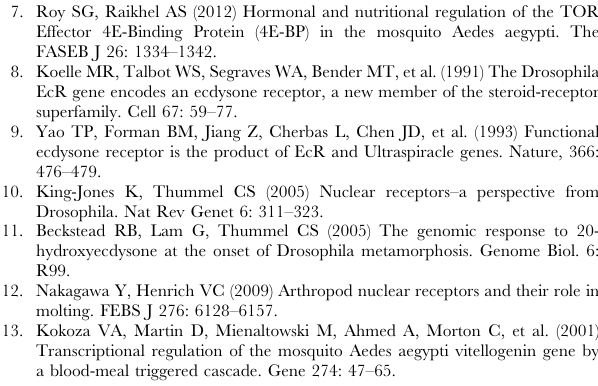
Figure S1 A schematic representation of the 20E- triggered regulatory interactions at the onset of Dro- sophila metamorphosis. The green ovals – EcR/USP 20E heterodimeric receptor; blue boxes – genes that encode 20E regulated transcription factors (early genes); orange boxes – late target genes. Green arrows represent activating effects and red lines represent repressive effects. From [46] with permission. (PDF) Figure S2 Effect of HR3 RNAi depletion on Vg and AaHR3 mRNA levels in the in vitro fat body tissue culture. Three days after dsRNA injection to Aedes female mosquitoes, their FBs were dissected and incubated for 6 h in the presence (20E) or absence (CM) of 1 microM 20E. HR3 (A) and Vg (B) relative mRNA levels were measured by means of qPCR. Each time point is the average ( 6 SEM) of three groups of three FBs. Samples were normalized to their internal control ribosomal protein-7 mRNA. The experiment was repeated three times with different cohorts of mosquitoes. *Indicates statistical significance , 0.05. (PDF) Figure S3 Effect of dsHR3 RNAi on mRNA transcript levels of genes involved in 20E response in the in vitro fat body tissue culture. Mosquitoes were injected with 1 m g of dsHR3 or dsMal RNAi. Three days later, FBs were dissected and incubated in a complete culture medium in the presence (20E) or absence (CM) of 1 microM 20E for 6 h or 14 h. In another experiment, FBs from similarly treated female mosquitoes were incubated in the 20E-containg medium for 6h, followed by 8 h incubation in the media (CM) without the hormone. Transcript levels of Vg, HR3, EcR-A, EcR-B, USP-A, USP-B, and betaFTZF1-B mRNAs were measured by means of qPCR. Each time point represents the average ( 6 SEM) of three groups of three FBs. Each sample was normalized to its internal control ribosomal protein-7 mRNA. Each experiment was repeated three times. *Indicates statistical significance ,